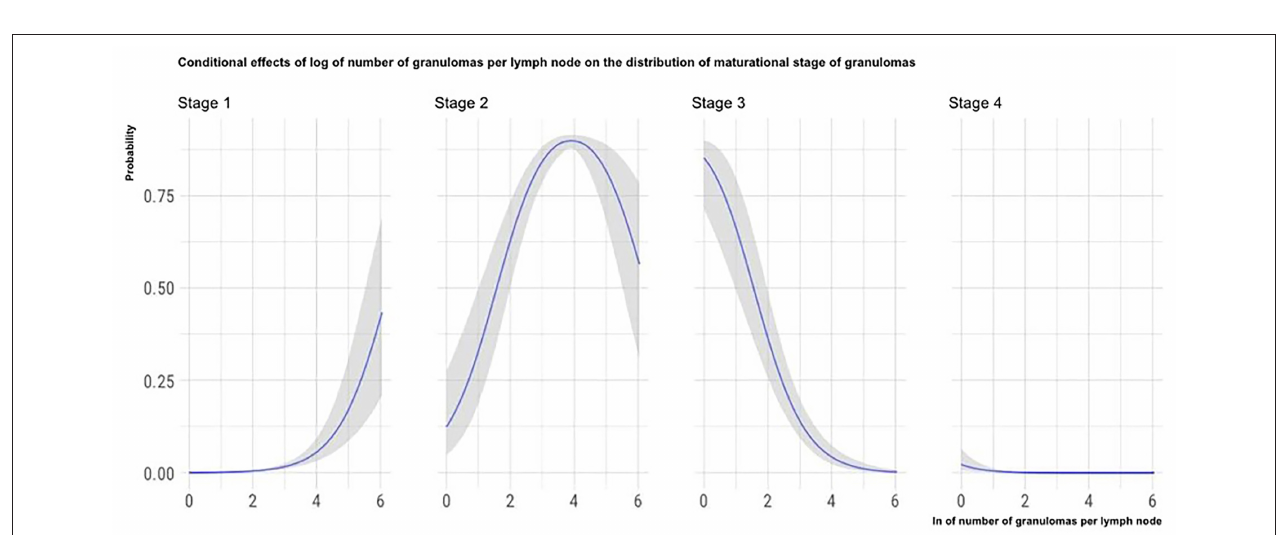
FIGURE 5 | Marginal effects of the total number of granulomas per LN on granuloma histological stage. The figure shows that as the total number of granulomas per LN increases, the possibility that granulomas contained in the considered LN are classified in the high histological stages